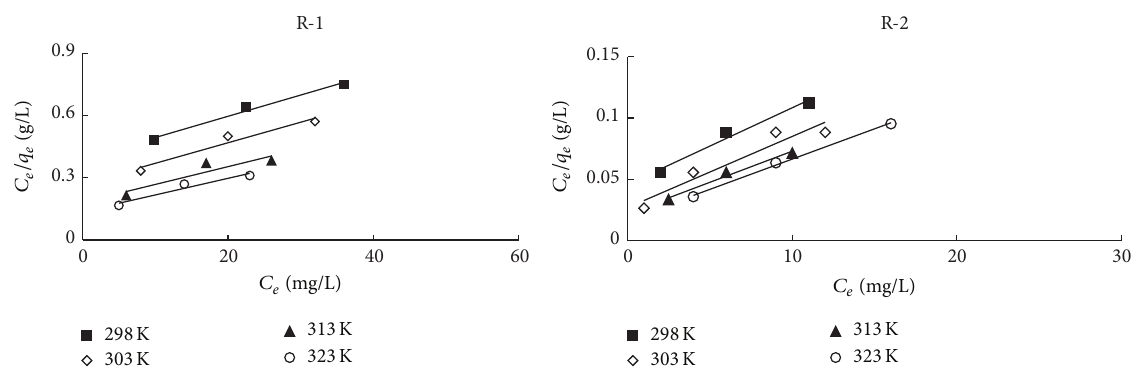
Figure 7: Langmuir adsorption